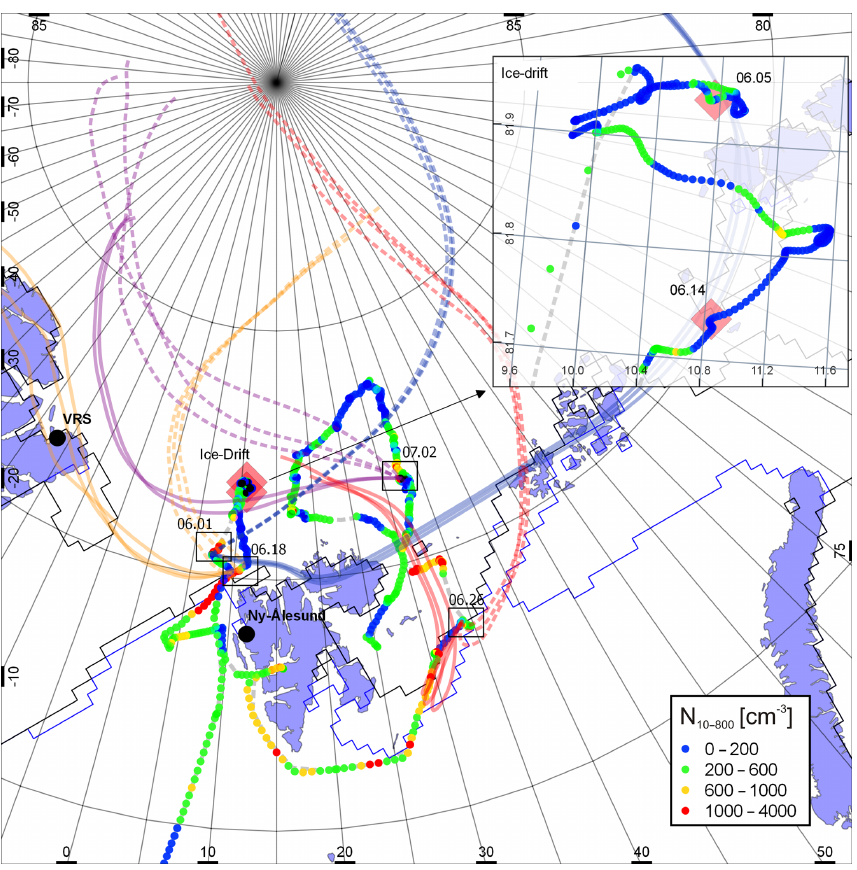
Figure 1. Cruise track and particle number concentration (integrated in a size range from 10 to 800nm) during PASCAL and SiPCA expeditions. The days which were picked to analyze NPF events and subsequent particle growth are indicated with square boxes. Backward air mass trajectories (72h) were calculated using HYSPLIT (Draxler and Rolph, 2012) and are shown by solid (200ma.s.l) and dotted (2000ma.s.l) lines corresponding to each NPF event. Ice drift is shown in the insert. Thin blue and black lines are the observed ice edge for June and July 2017, respectively (Fetterer et al.,